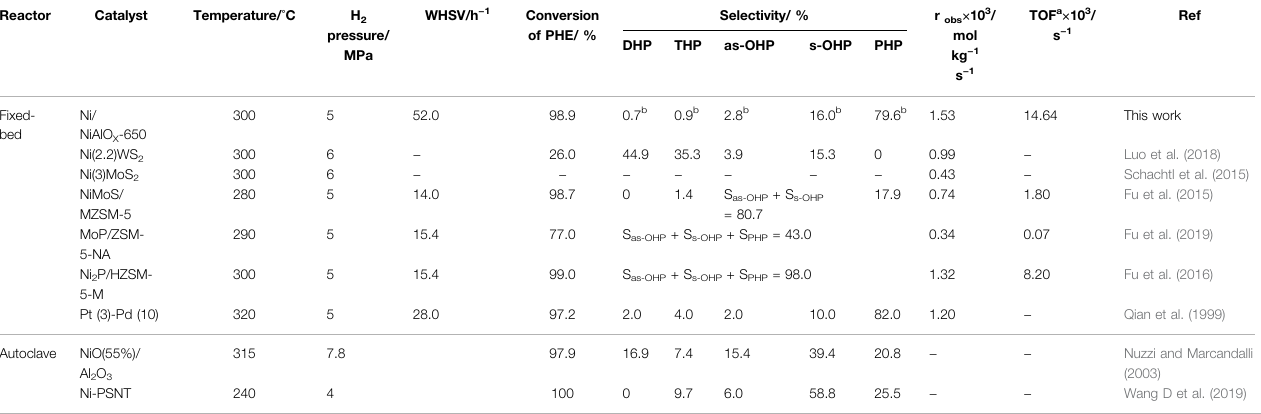
TABLE 3 | Comparison of the catalytic performance of Ni/NiAlO X -650 with the literature in the deep hydrogenation of phenanthrene. Reactor